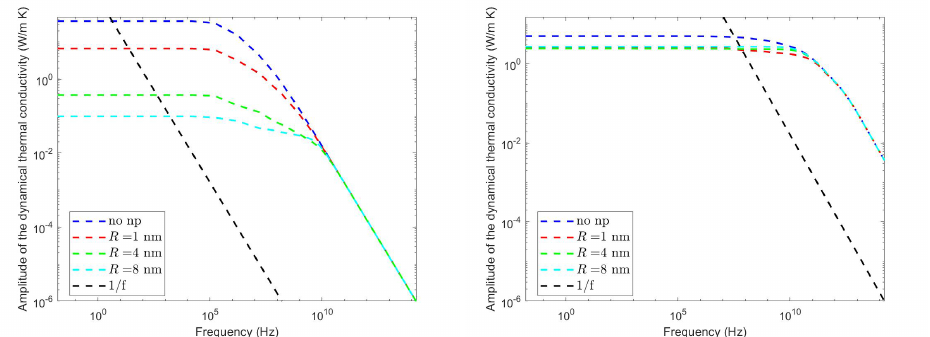
Figure 13. Amplitude of the dynamical thermal conductivity versus f , for f np = 4%. ( Left ): T = 5 K. ( Right ): T = 300 K. The black continuous–dotted lines behave like 1/ f .